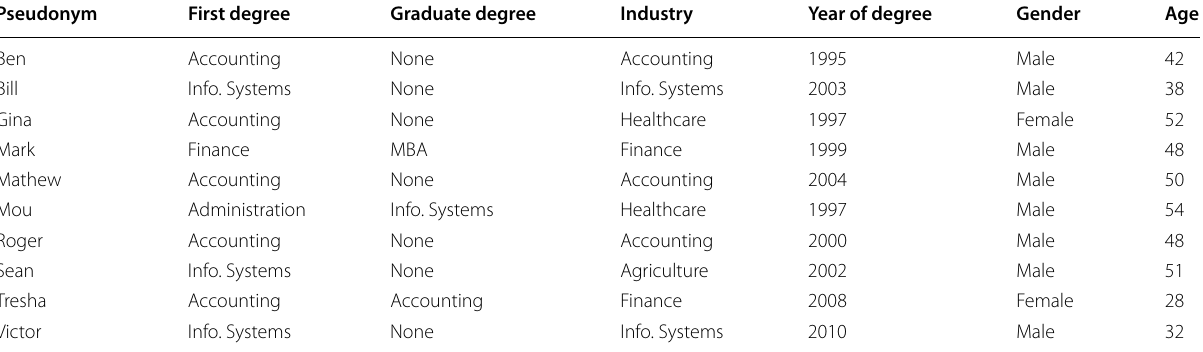
Table 1 Participants’ demographic and basic work